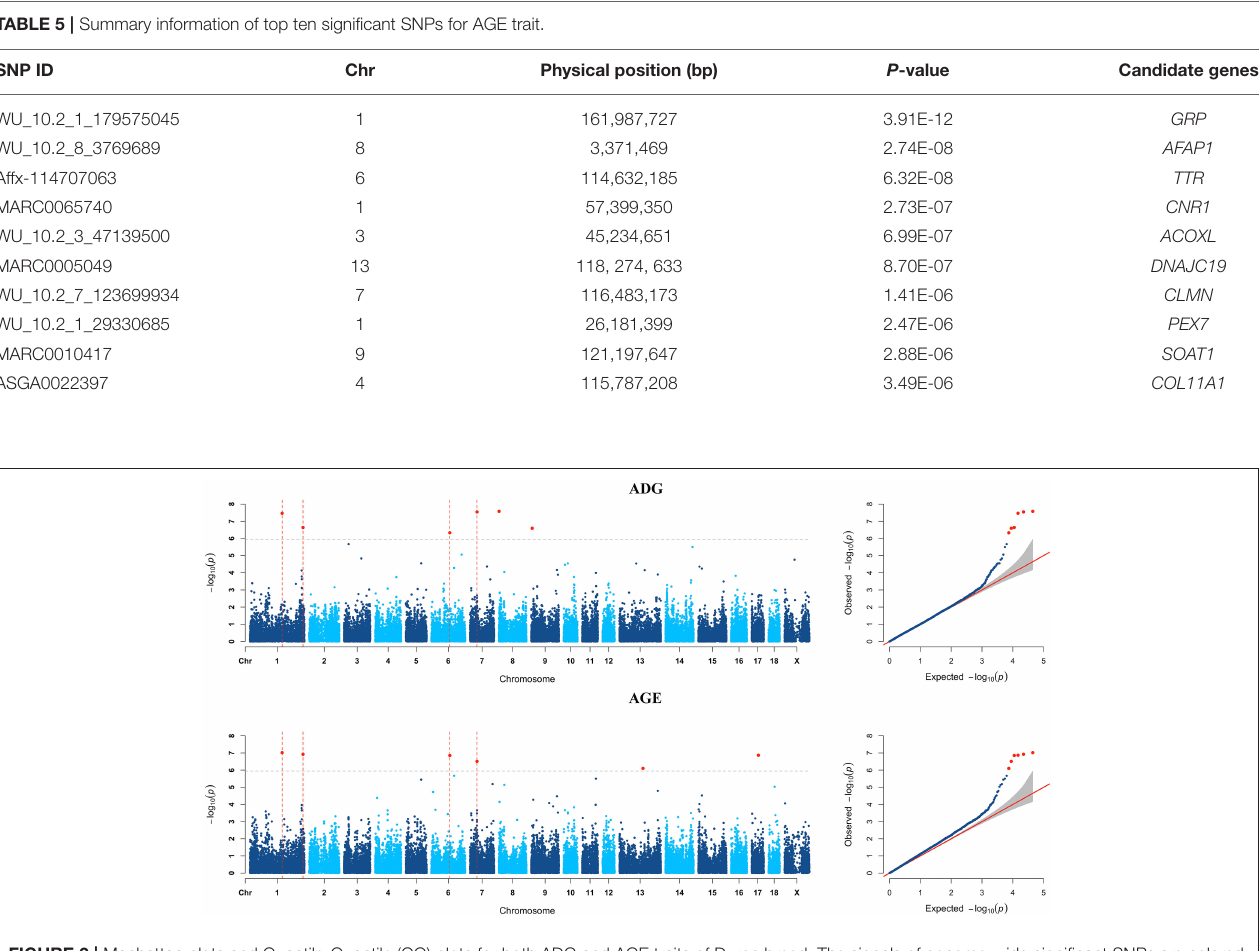
TABLE 4 | The proportion of genetic variance and phenotypic variance explained by candidate regions. Trait No. of randomly selected regions Vg ± SE Vp ± SE No. candidate regions Vg Vp ADG 5 0.663 ± 0.0013% 0.311 ± 0.0006% 5 4.08% 1.90% AGE 6 0.669 ± 0.0010% 0.304 ± 0.0005% 6 8.09% 3.52% Vg, Proportion of Genetic Variance; Vp, Proportion of Phenotypic Variance.